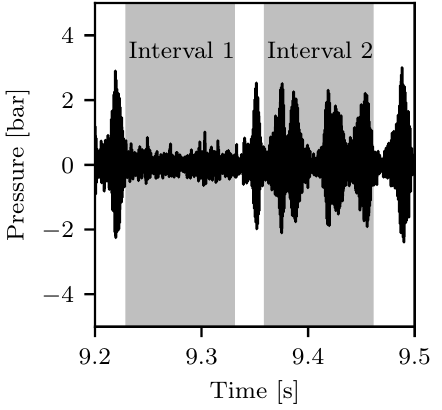
Figure 15. High-pass filtered signal of p (cid:48)